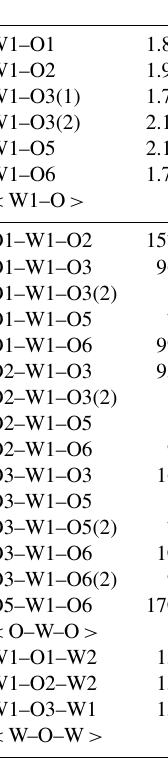
Table 4. Selected geometric parameters (Å, ◦ ) for liguowuite.